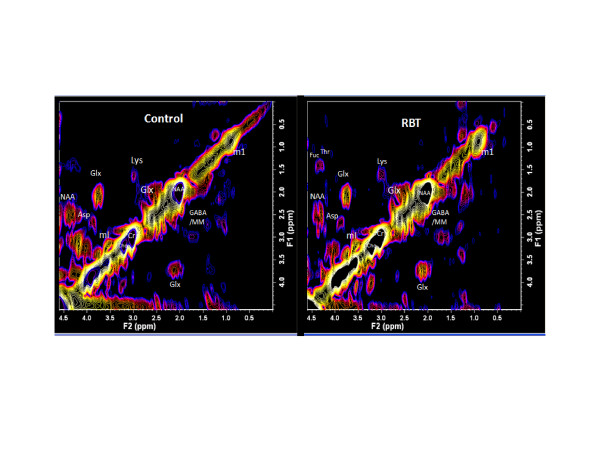
L-COSY spectra from healthy control (left) and athlete with a history of repetitive brain trauma (RBT; right). Spectroscopy was performed at 3T using a 32 channel head coil and voxel size of 3 × 3 × 3 cm3 in the posterior cingulated gyrus; increment size 0.8 ms; 64 increments with 8 averages resulting in an acquisition time of 12.8 minutes; acquired vector 1,024 points; acquisition time 512 ms; spectral width in F2 2,000 Hz and spectral width in F1 1,250 Hz. For presentation the spectra were calibrated to the lysine cross peak at 3.00 to 1.67 ppm. Asp, aspartate; Cho, choline; Cr, creatine; Fuc, fucose; GABA, gamma-aminobutyric acid; Glx, glutamate/glutamine; Lys, lysine; m1, macromolecule; mI, myo-insitol; NAA, N-acetyl aspartate; Thr, threonine.